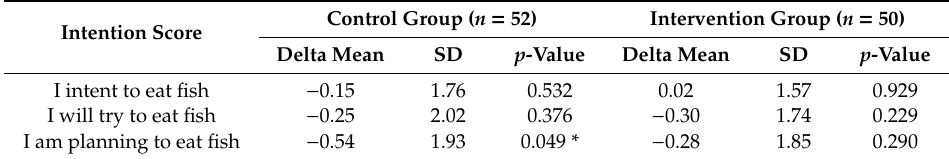
Table 6. Change in children’s intention towards fish consumption after 3 months of intervention.